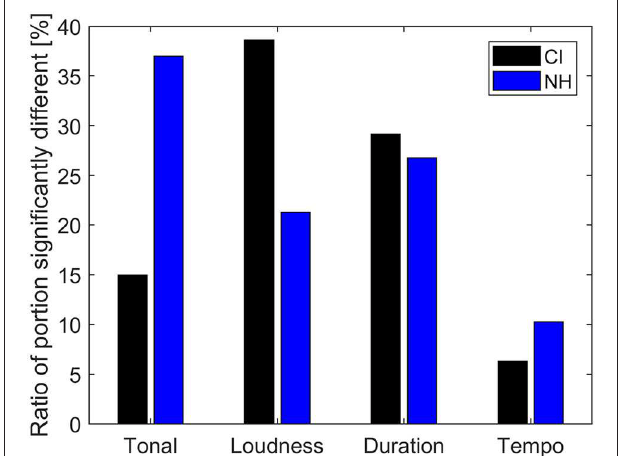
FIGURE 7 | Ratio of rating significantly different from the baseline for the four modified conditions: random pitch (Tonal), fixed intensity (Loudness), fixed duration (Duration) and enhanced tempo variation (Tempo).